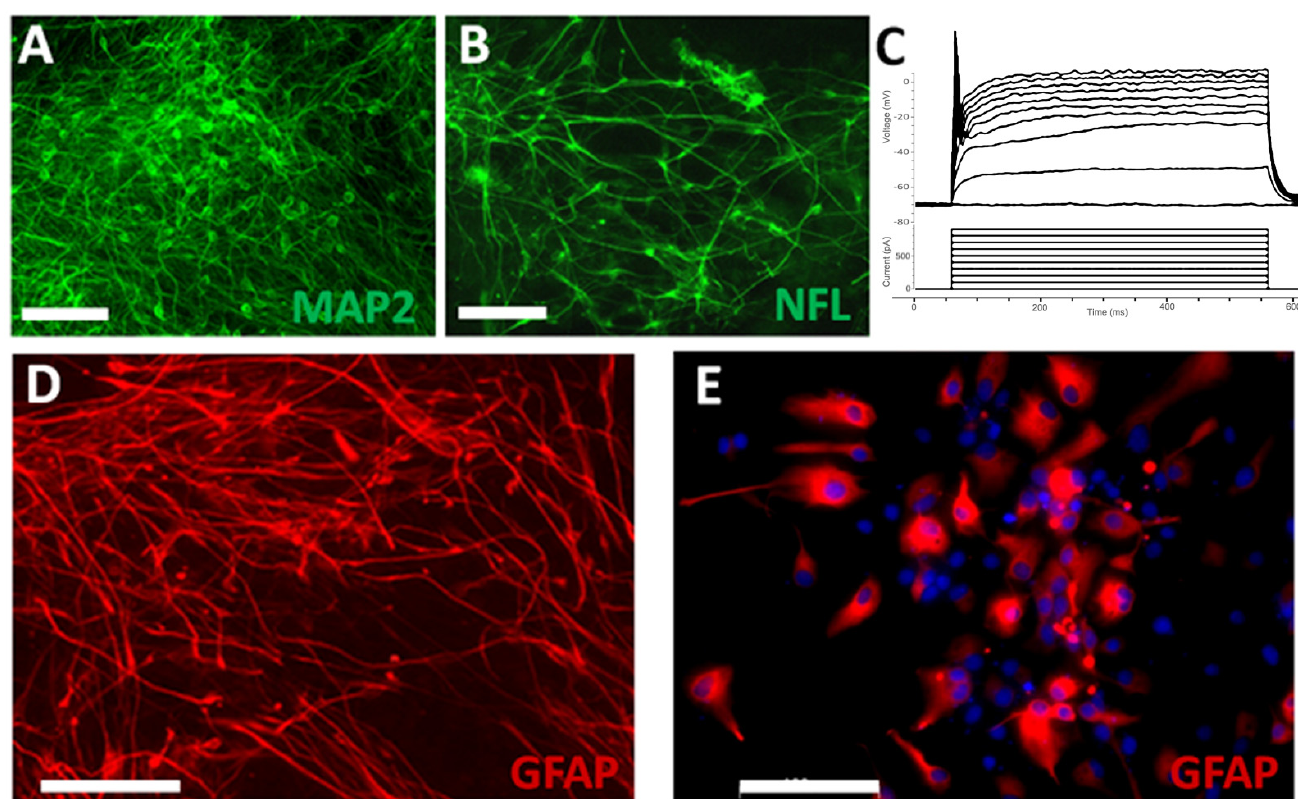
Figure 2. Differentiation of the purified hiPSC-derived NPCs. After differentiation in the neuronal differentiation medium for 2 weeks, many NPCs differentiated into mature neurons expressing MAP2 ( A ) and NFL ( B ). These differentiated neurons were able to generate action potentials during patch clamp recording ( C ). After differentiation in the astrocyte differentiation medium for 1 month, many NPCs differentiated into immature GFAP+ astrocytes with stellate morphology and long processes ( D ). After differentiation for 3 months, most astrocytes became more mature with increased size in cytoplasm and fewer processes ( E ). Scale bars: 100 μ m.